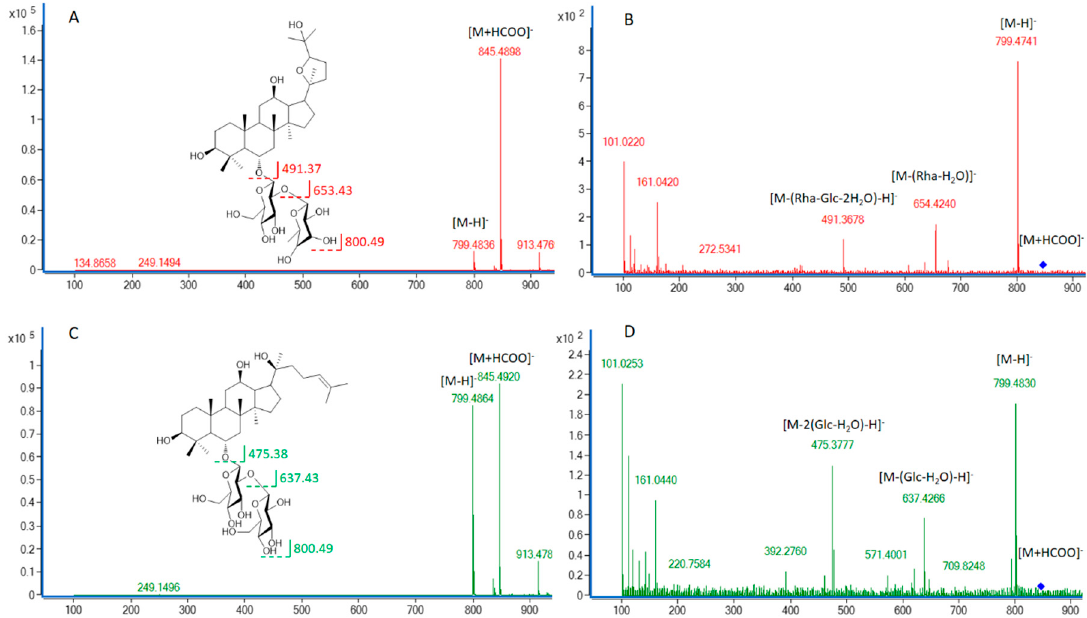
Figure 3. The MS ( A , C ) and MS 2 ( B , D ) of ginsenosides p ‐ F11 ( A , B ) and Rf ( C , D ).